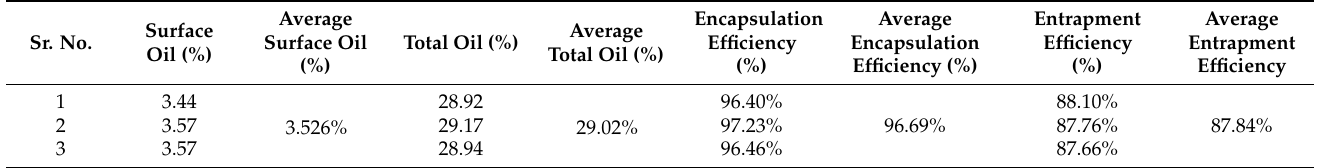
Table 5. Total oil, surface oil, and encapsulation efficiency of Modified Starch.